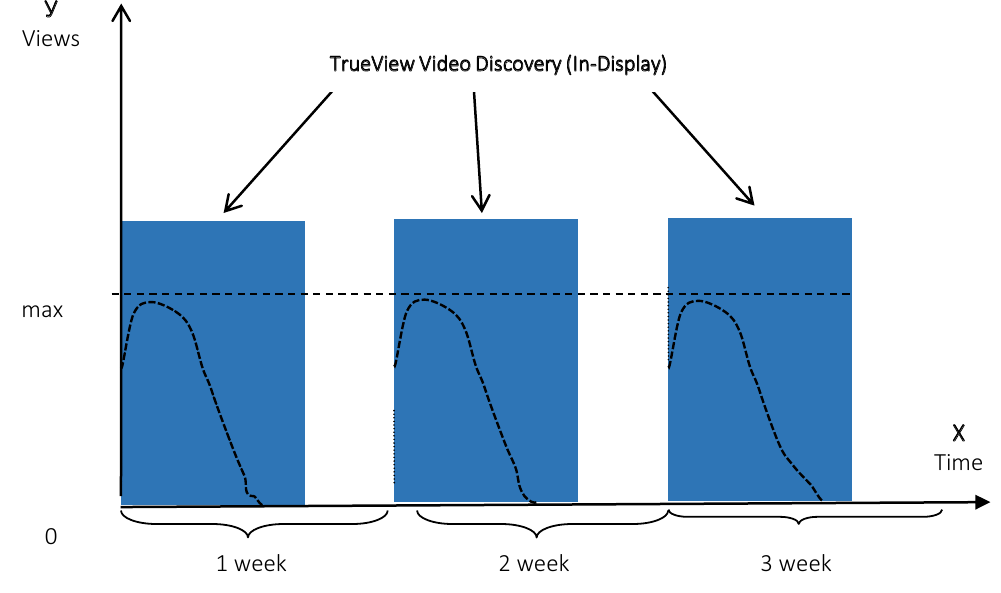
Figure 12. Effects of advertising reviews (dashed